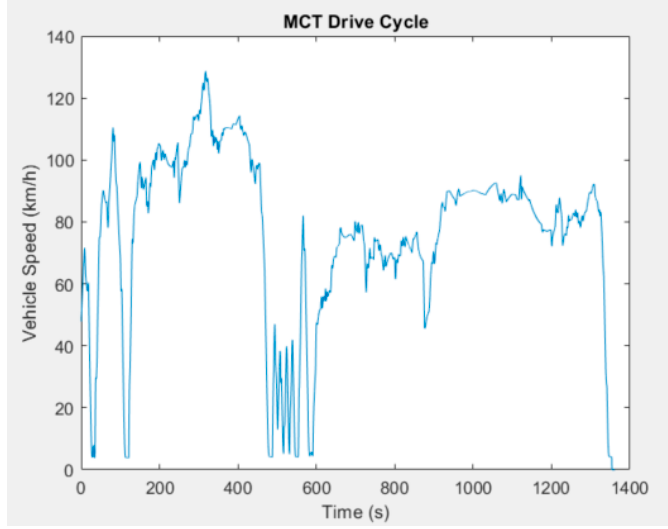
Figure 3. Multi-Cycle Test (MCT) drive cycle, reducing the testing time of EVs. The total time and distance for this MCT test was ~22 min and 18.26 miles (29.3 km).